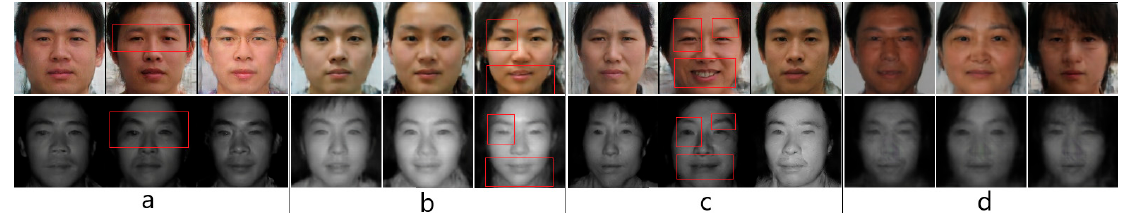
Figure 8. Generated results for the ablation study with contrast experiments ( a – d ). ( a ) The same z code. ( b ) Without the self-aligned block. ( c ) Normal weighted reconstruction loss. ( d ) Without a multiscale patch discriminator.